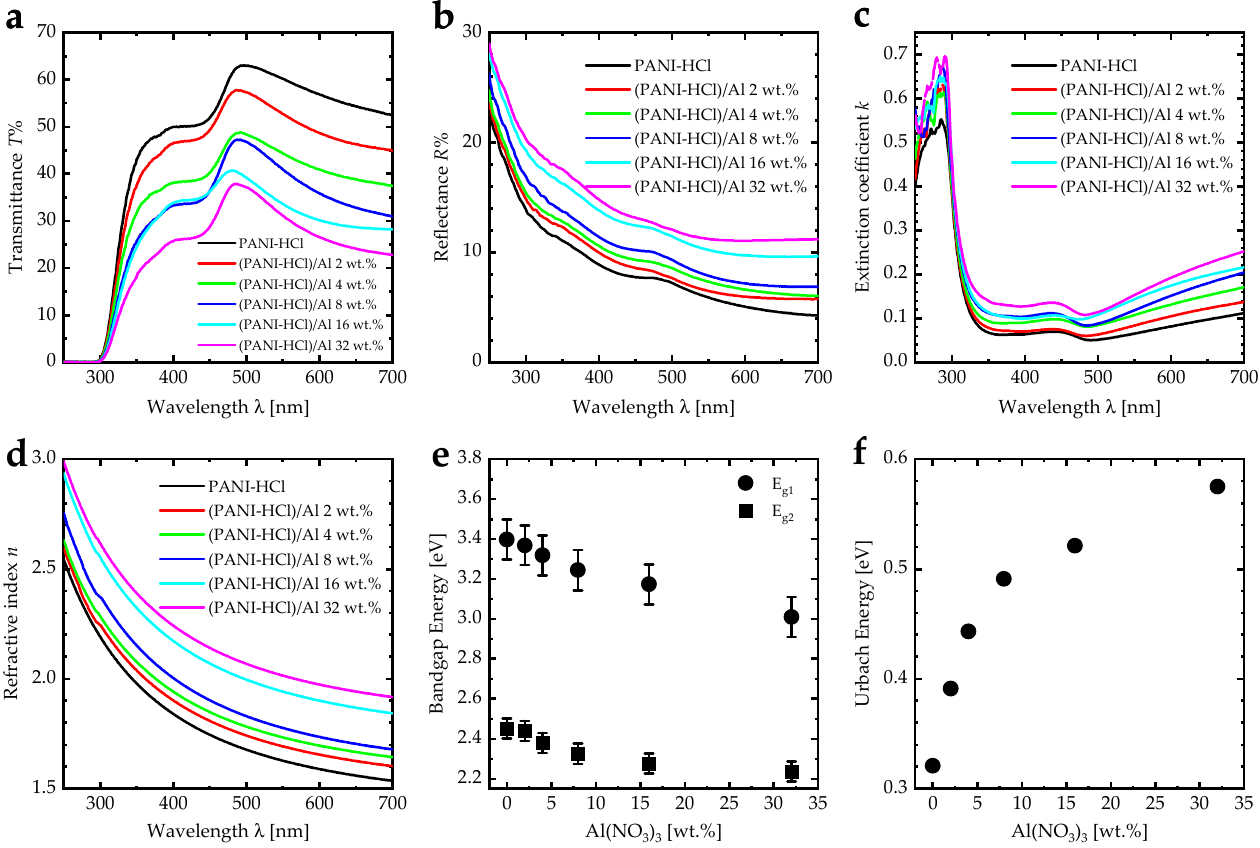
Figure 6. ( a ) Transmittance spectra, ( b ) reflectance spectra, ( c ) extinction coefficient spectra, ( d ) refractive index spectra, ( e ) bandgap energy, and ( f ) Urbach energy for (PANI-HCl)/Al(NO 3 ) 3 complex composite films with varying Al(NO 3 ) 3 concentration.